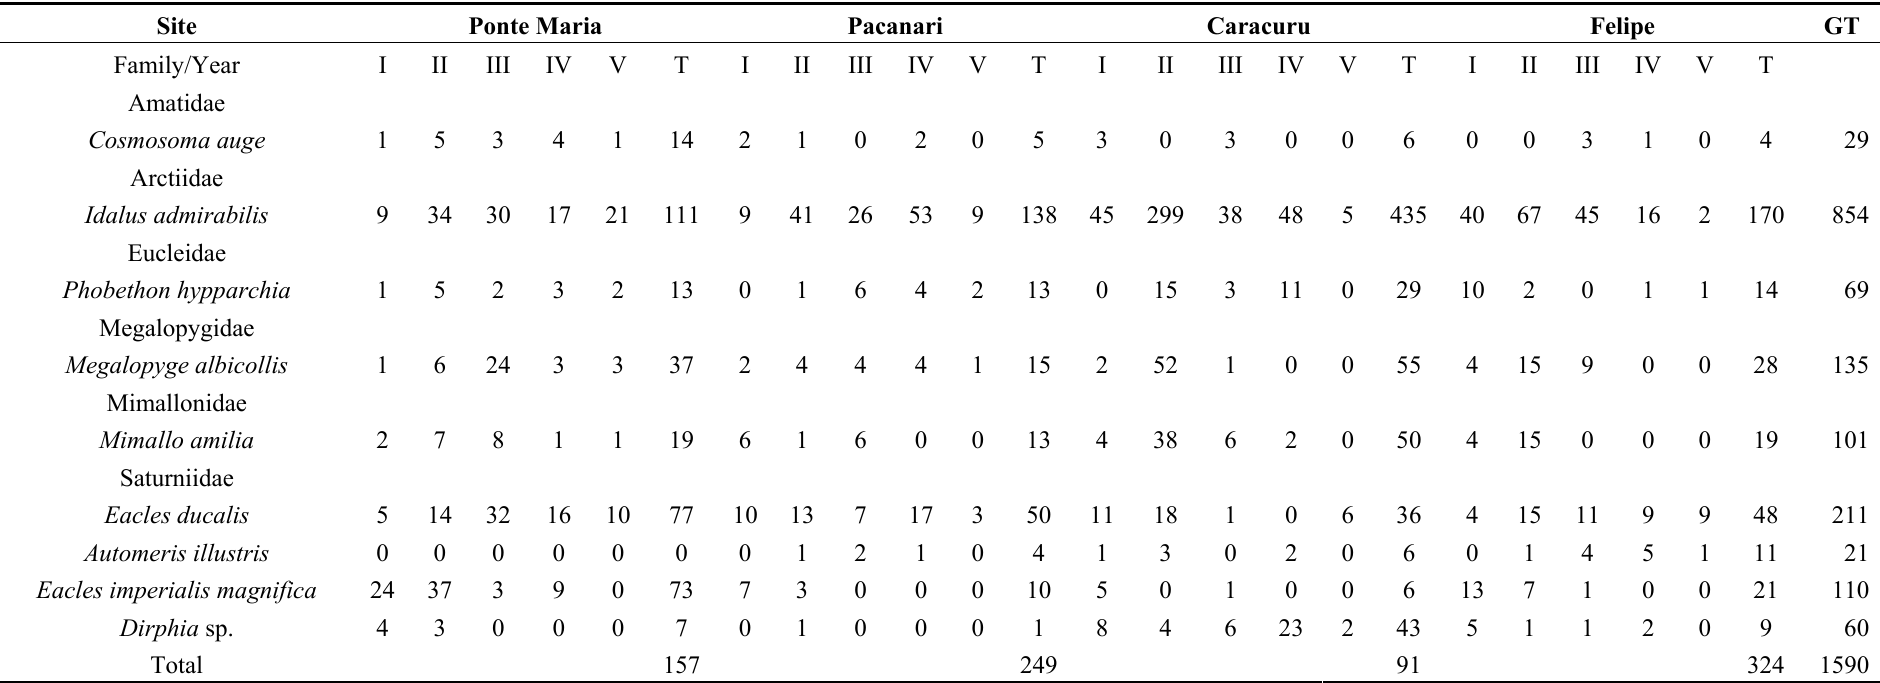
Table 3. Number of individuals of Lepidoptera secondary pest species collected in Eucalyptus urophylla plantations in Monte Dourado, Pará and Amapá States, Brazil. T is Sub-total; GT is Grand